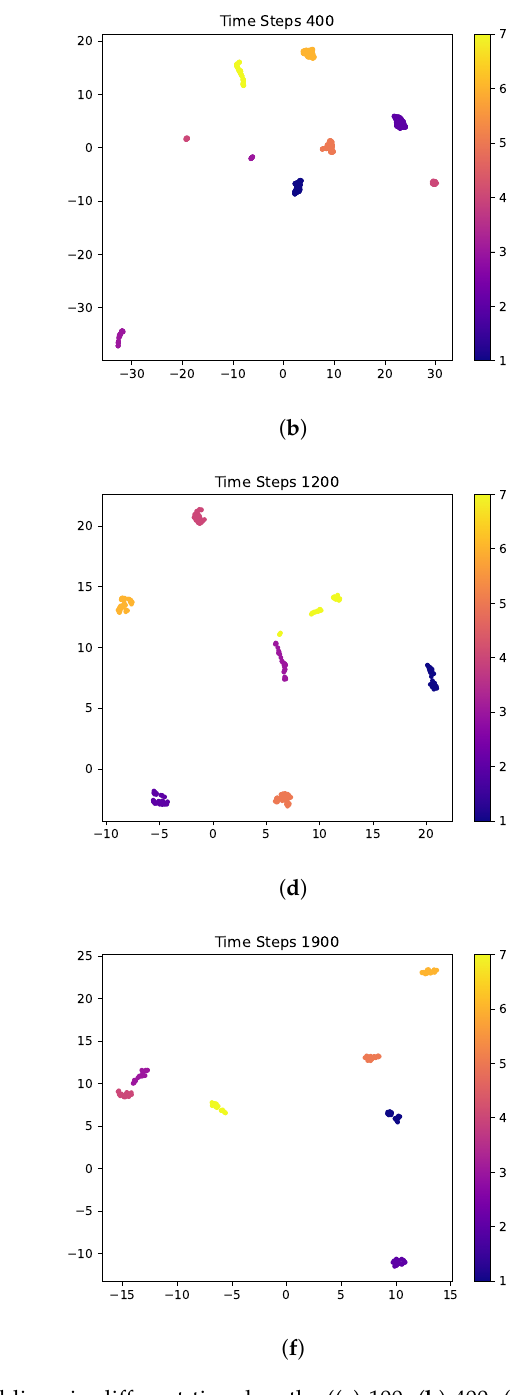
Figure 12. Examples of embeddings in different time lengths (( a ) 100; ( b ) 400; ( c ) 800; ( d ) 1200; ( e ) 1500; ( f ) 1900) used for a single data point (Dataset